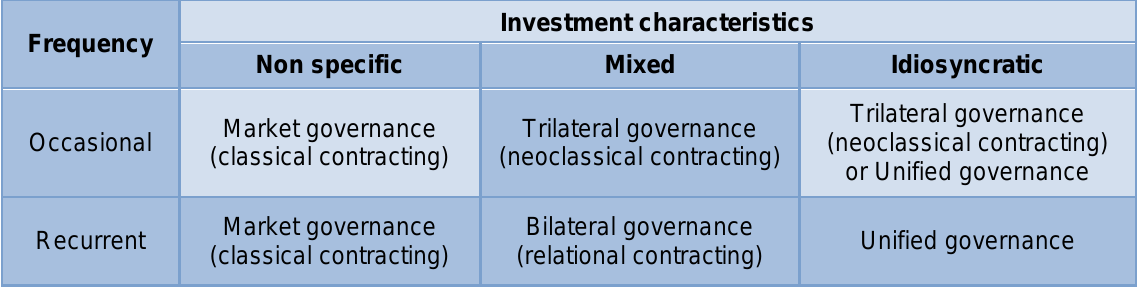
Table 4 Alternative governance structures (based on Williamson,